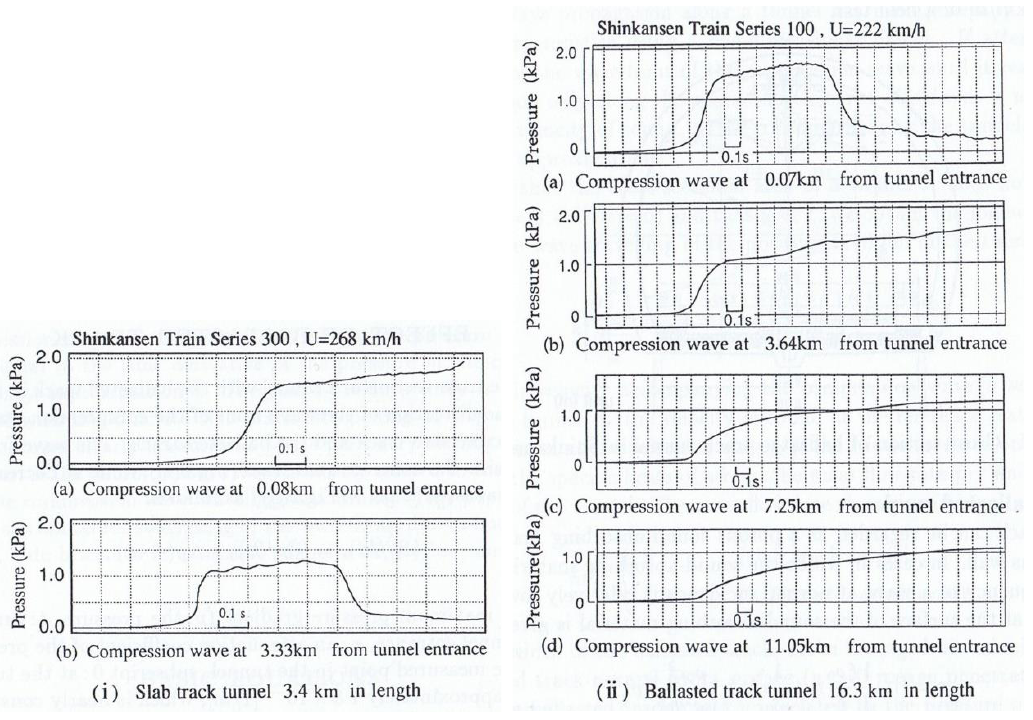
Figure 8. Compression waves in long, ballast-track and slab-track tunnels (after Ozawa et al. [16]. N.B.: The strong pressure reduction at 3.33 km in the slab-track tunnel is a reflection from the tunnel exit portal whereas the strong reduction at 0.07 km in the ballast-track tunnel occurred when the train nose passed the sensor).